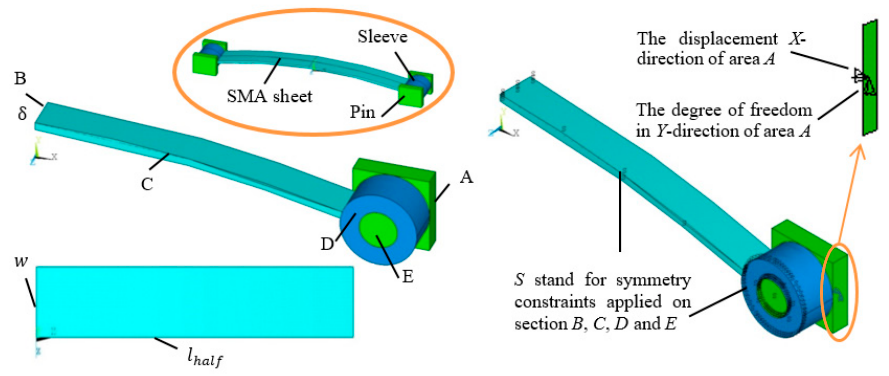
Figure 5. The C-shaped SMA model and the 1 / 4 part of the model for l half as a design variable used in optimization.